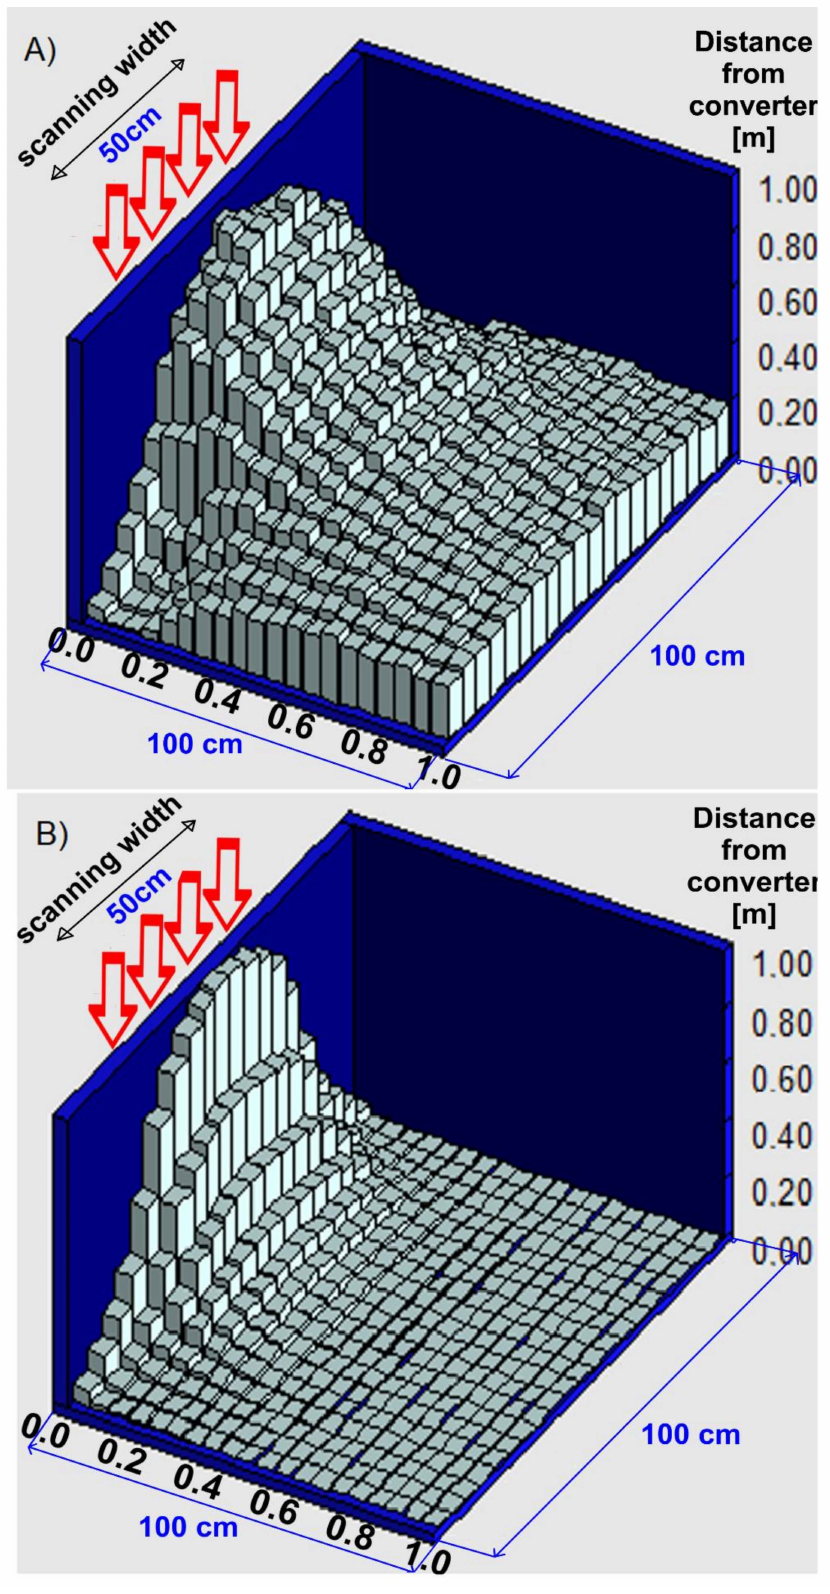
Figure 6. Energy deposition in: ( A ) air and ( B ) water of bremsstrahlung radiation generated by elec- trons of energy 930 keV in 5 mm thick water layer (converter) observed in a parallel and perpendicular direction to the scanned